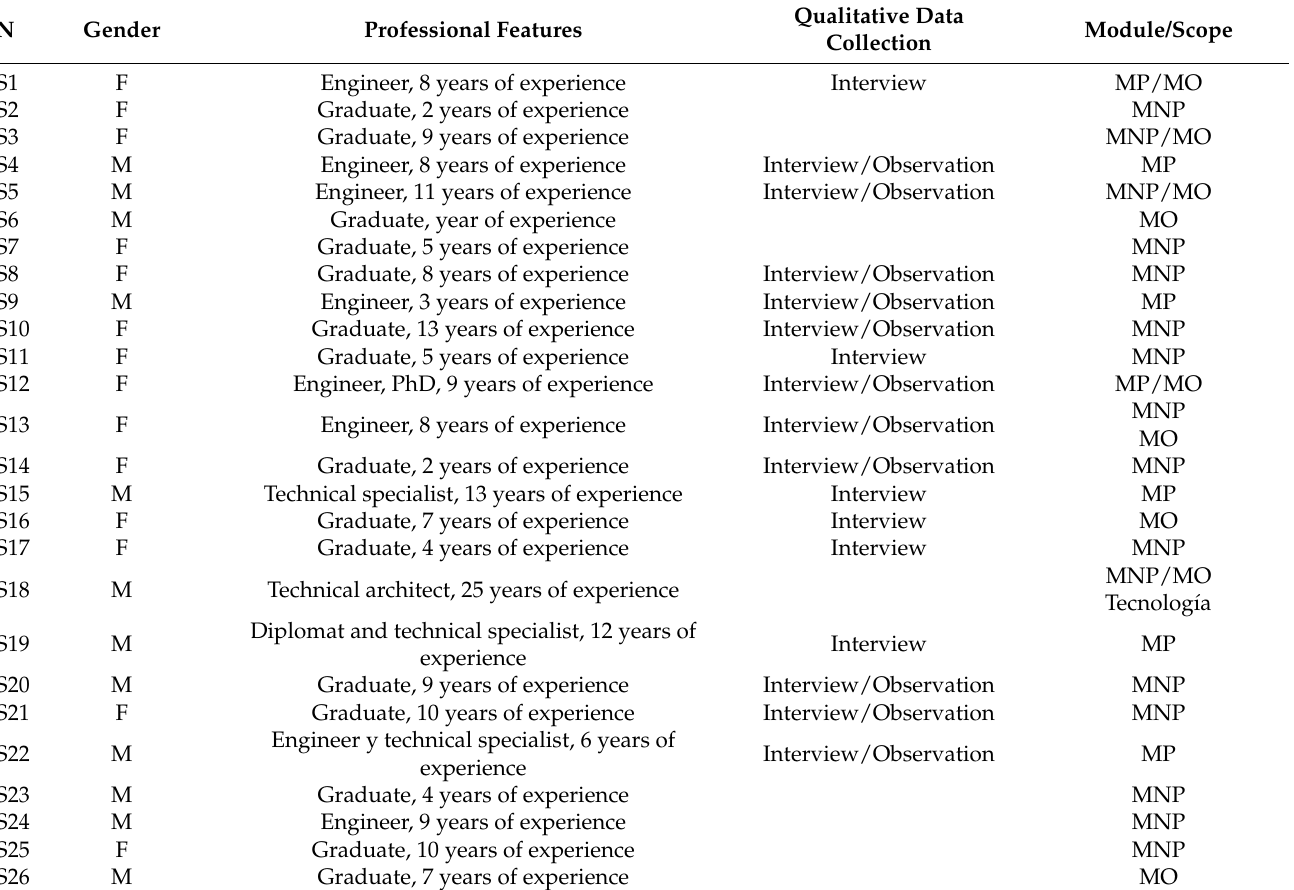
Table 1. Population/sample of participating